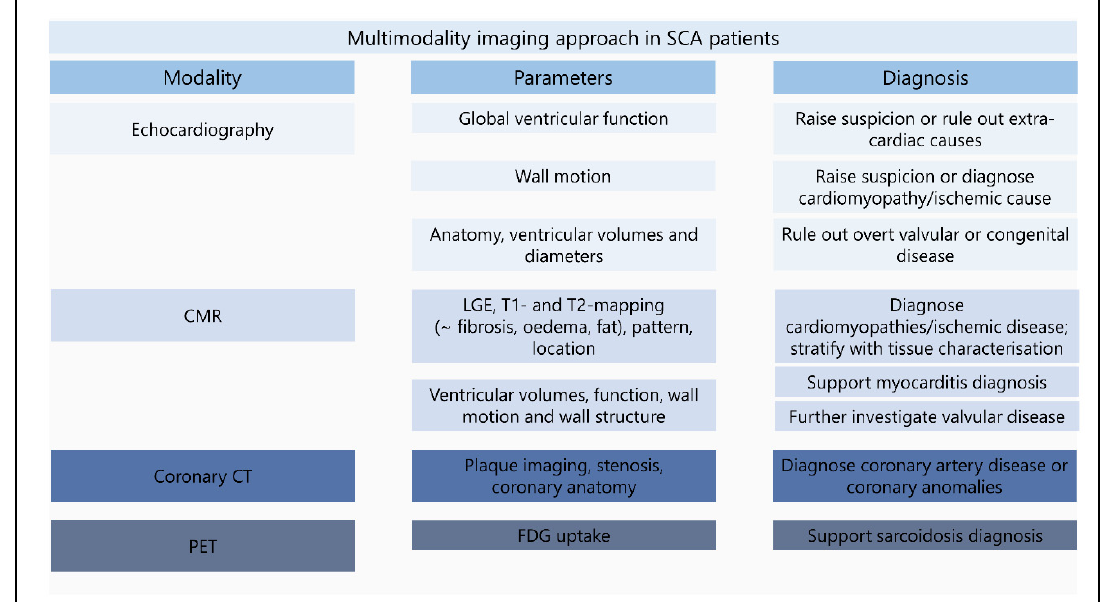
Figure 9. Multimodality imaging approach in sudden cardiac arrest survivors. The figure provides an overview of the minimum performed imaging modalities in sudden cardiac arrest survivors.